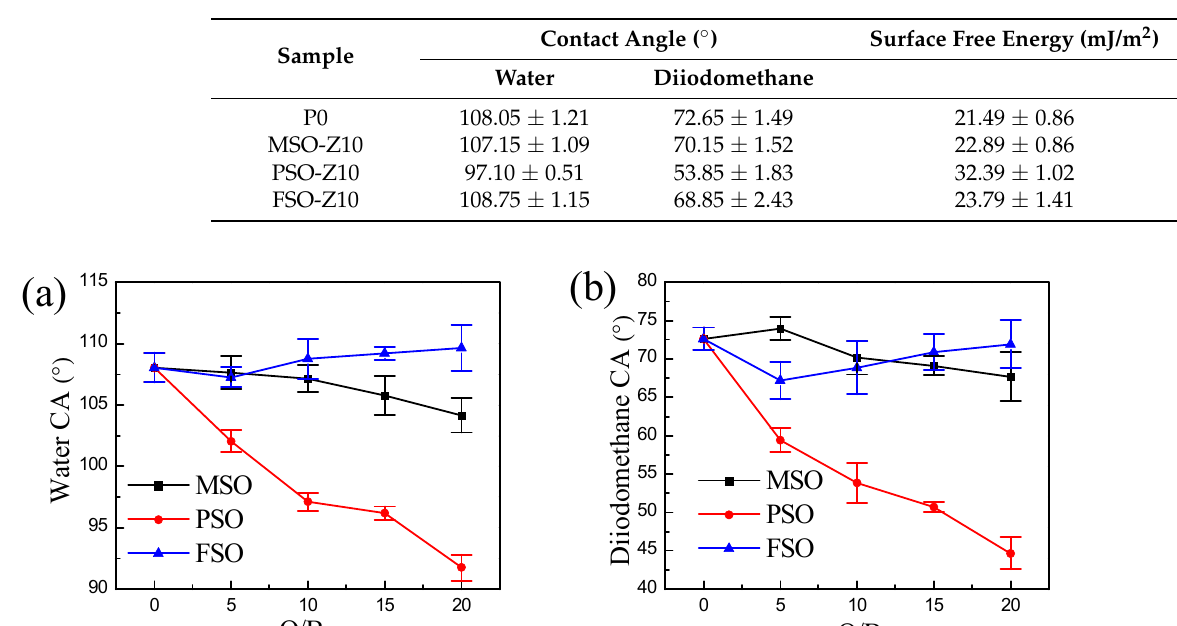
Table 2. The surface properties of different silicone oil/silicone coatings.